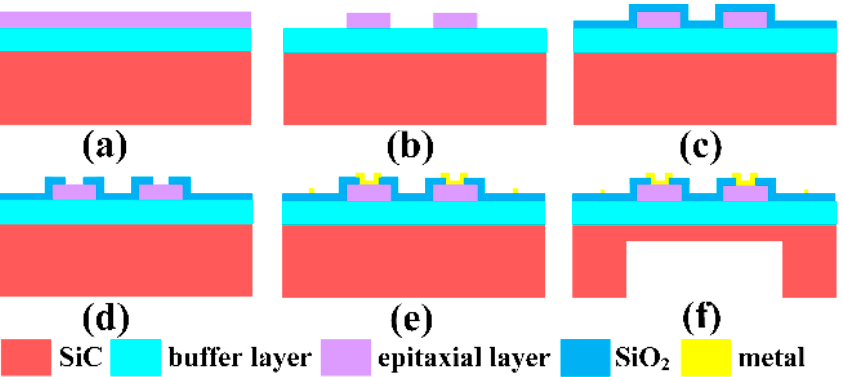
Figure 2. Process flow of sensor. ( a ) Structure diagram of SiC epitaxial wafer. ( b ) Varistors were shallowly etched using reactive ion etching machine (RIE). ( c ) The SiO 2 was grown by thermal oxidation as an electrical isolating layer. ( d ) Ohmic contact holes were opened by wet corrosion of SiO 2 . ( e ) Metal electrodes were formed by metal deposition and metal stripping. ( f ) The pressure reference cavity of the sensor was deeply etched using inductively coupled plasma (ICP) machine.